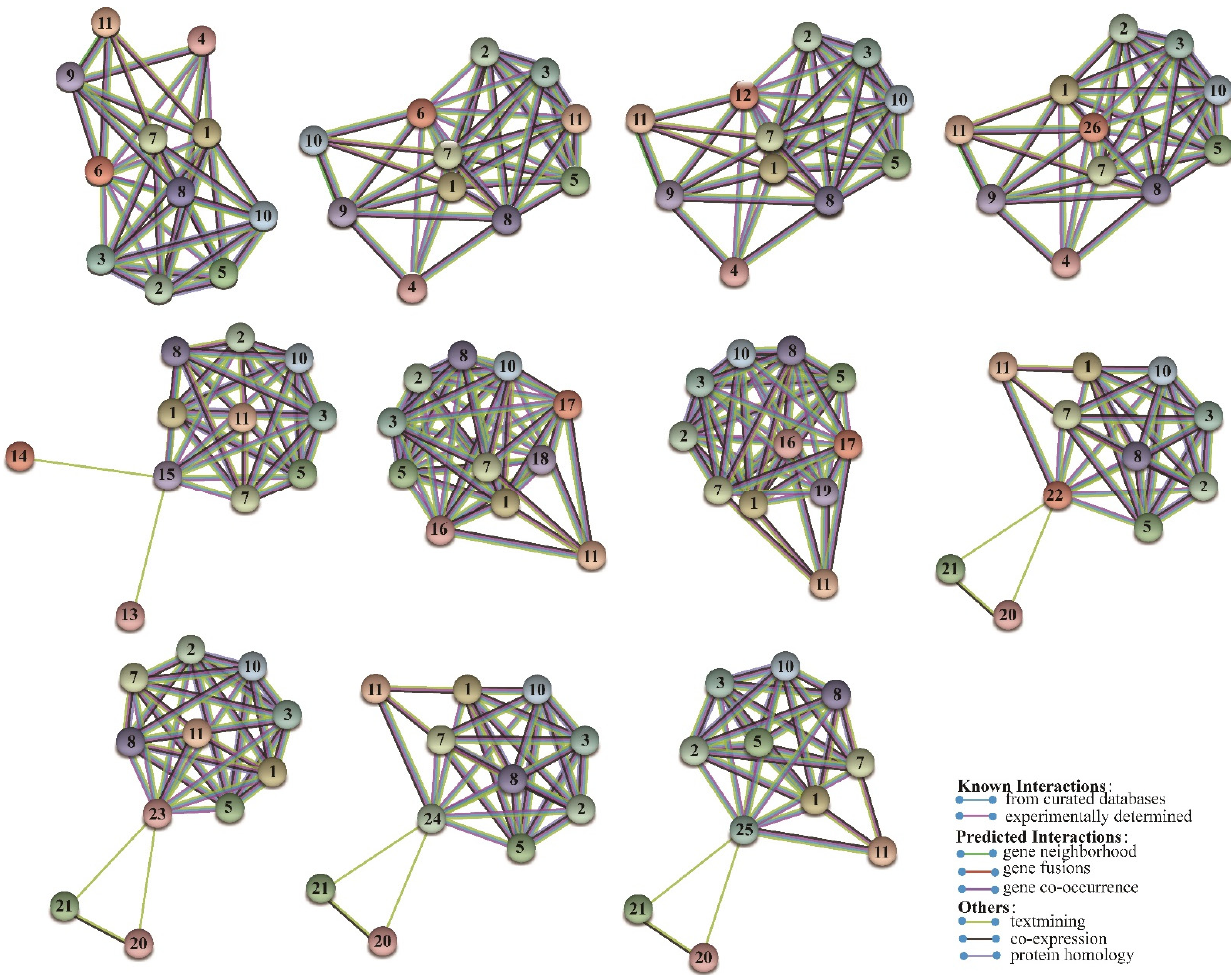
Figure 5. The predicted network of protein–protein interactions of PtriZATs by STRING. The different colors represent different types of interactions. The interaction proteins were as follows: 1,